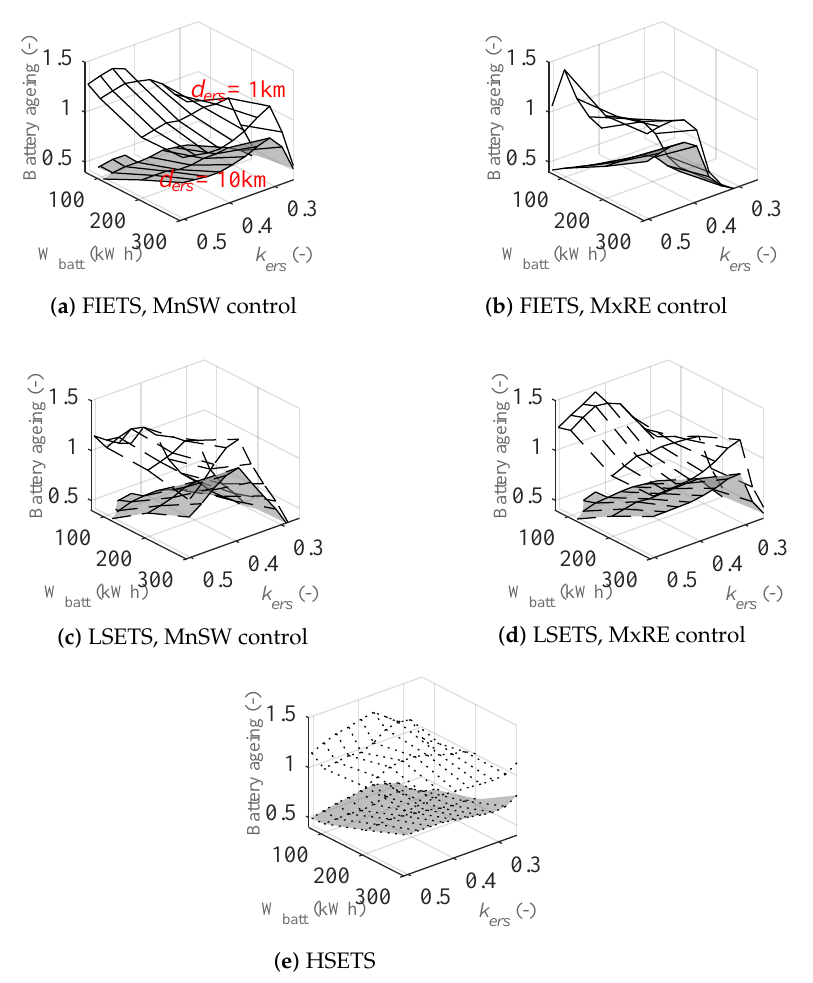
Figure 11. Relative battery ageing, ADA ERS placing over EQU ERS placing, of a city bus on ’City bus route 85’, as a function of the battery capacity, W batt , and the ratio of ERS-coverage, k ers . The non-filled dark surface corresponds to the ratio of the two placing methods where d ers = 1 km, the filled to where d ers = 10 km.